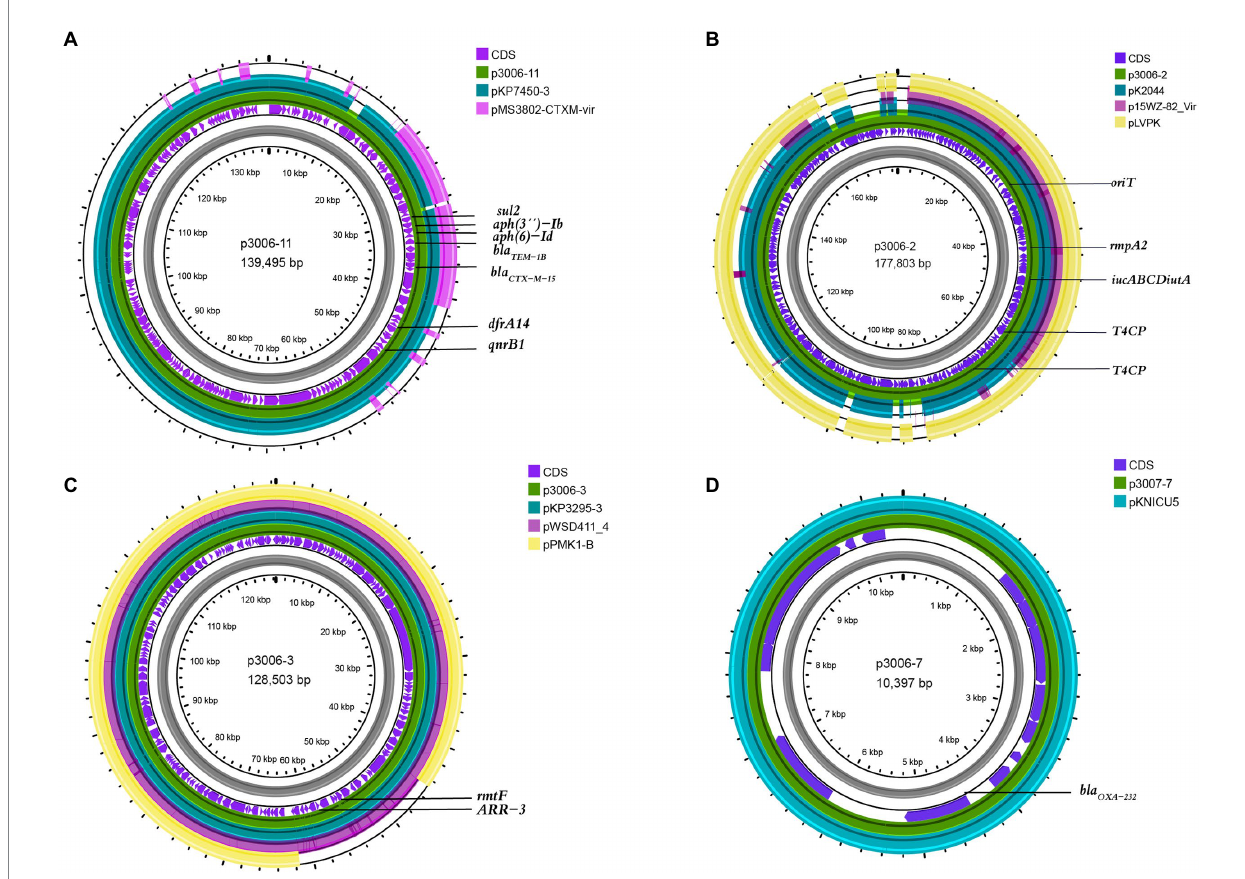
FIGURE 1 Comparative analysis of p3006-2, p3006-3, and p3006-7 plasmids with other reference plasmids. (A) Genome alignment was performed with p3006- 11(JANCTJ010000011), pKP7450-3(99.95%, CP090471.1), and pMS3802-CTXM-vir(99.59%, CP068016.1). (B) Genome alignment was performed with p3006-2(JANCTJ010000002), virulent plasmid pK2044 (99.46%, CP026012.1), mobilisable virulence plasmid p15WZ-82-Vir(99.53%, CP032356.1), and pLVPK(99.51%, AY378100). (C) Genome alignment was performed with p3006-3(JANCTJ010000003), pKP3295-3(99.98%, CP079728.1), pWSD411_4(99.98%, CP045677.1), and mobilisable plasmid pPMK1-B(99.96%, CP008931.1). (D) Genome alignment was performed with p3006- 7(JANCTJ010000007), and